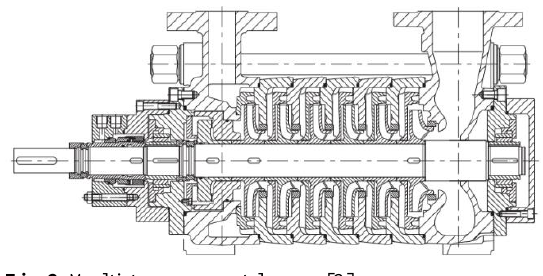
Fig. 2. Multistage segmental pump [2]